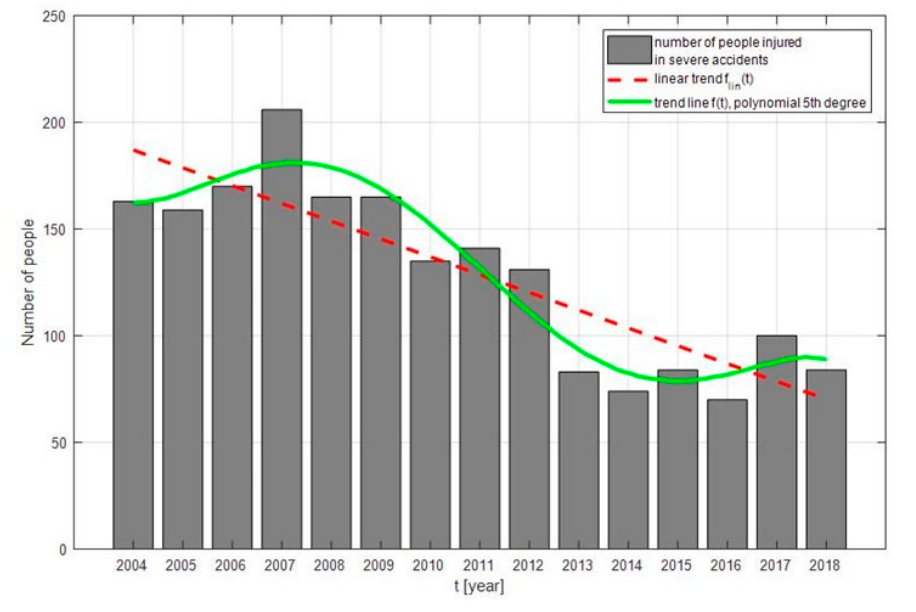
Figure 2. Trends of changes in the number of fatally injured civil engineering workers over time.